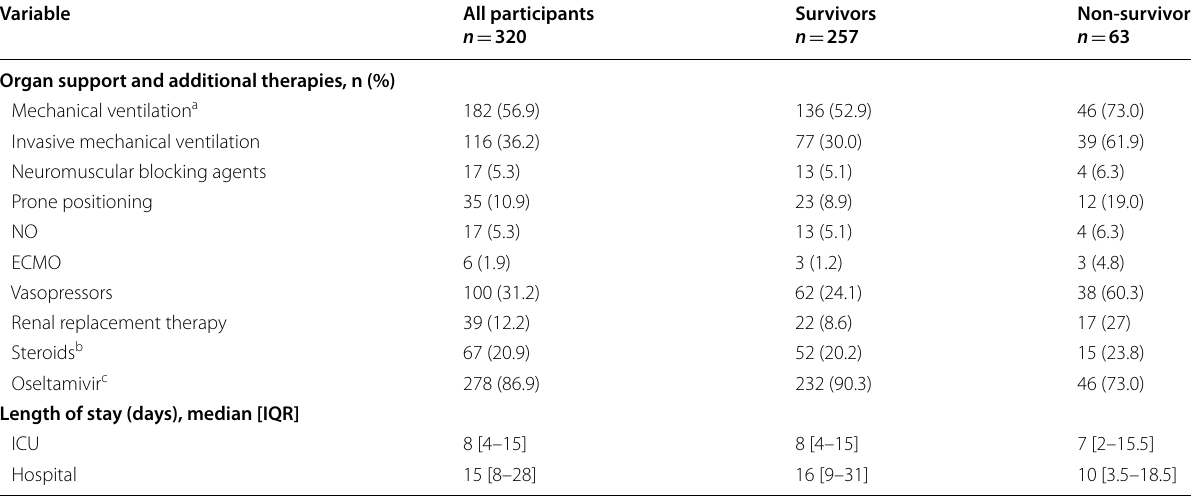
NO nitric oxide, ECMO extracorporeal membrane oxygenation a Invasive mechanical ventilation with endotracheal intubation, non-invasive positive pressure ventilation and high flow nasal oxygen therapies were included in the category mechanical ventilation b Steroids included hydrocortisone and methylprednisolone